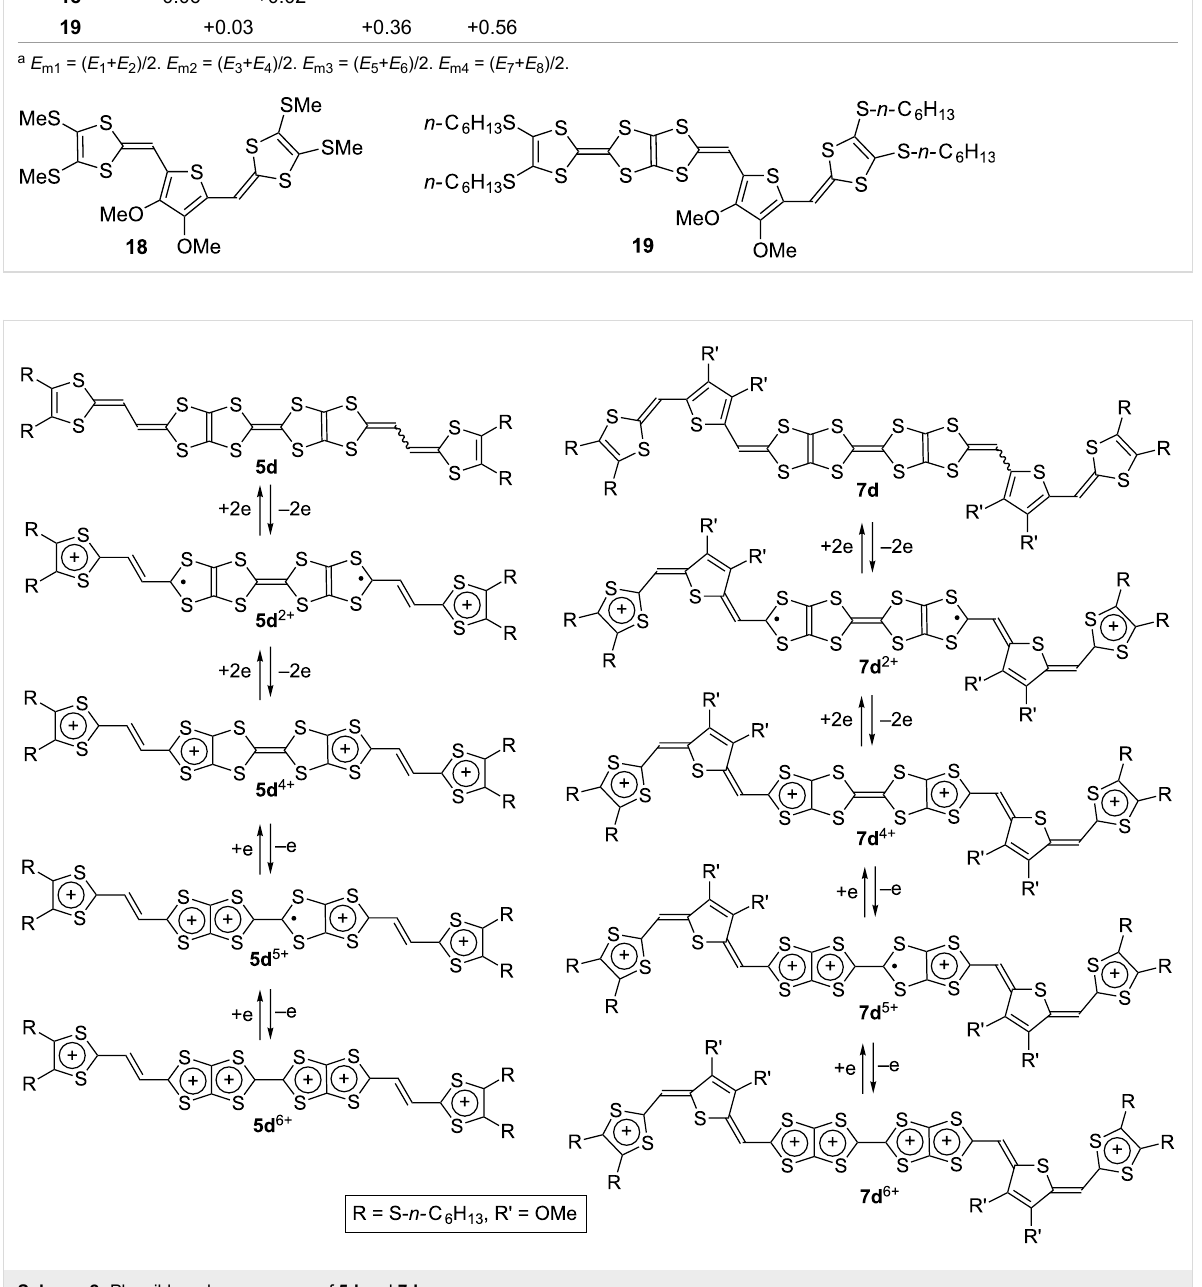
Scheme 2: Plausible redox processes of 5d and 7d